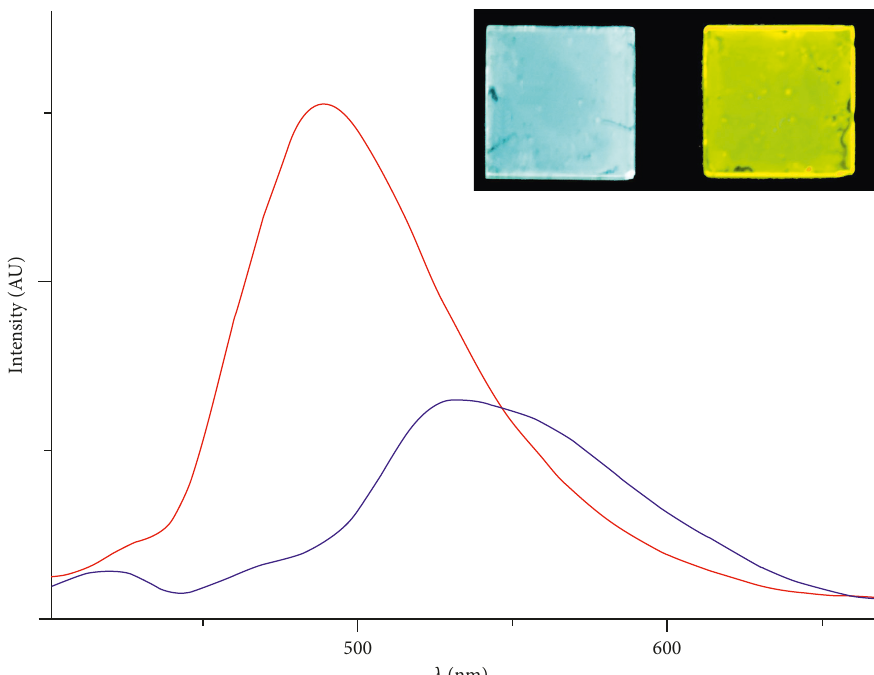
Figure 2: NPh2 (blue curve) and NPh5 (red curve) emission spectra recorded on neat solid films excited at 340nm. Inset: neat solid films of NPh2 and NPh5 photographed under a UV lamp at 365nm.